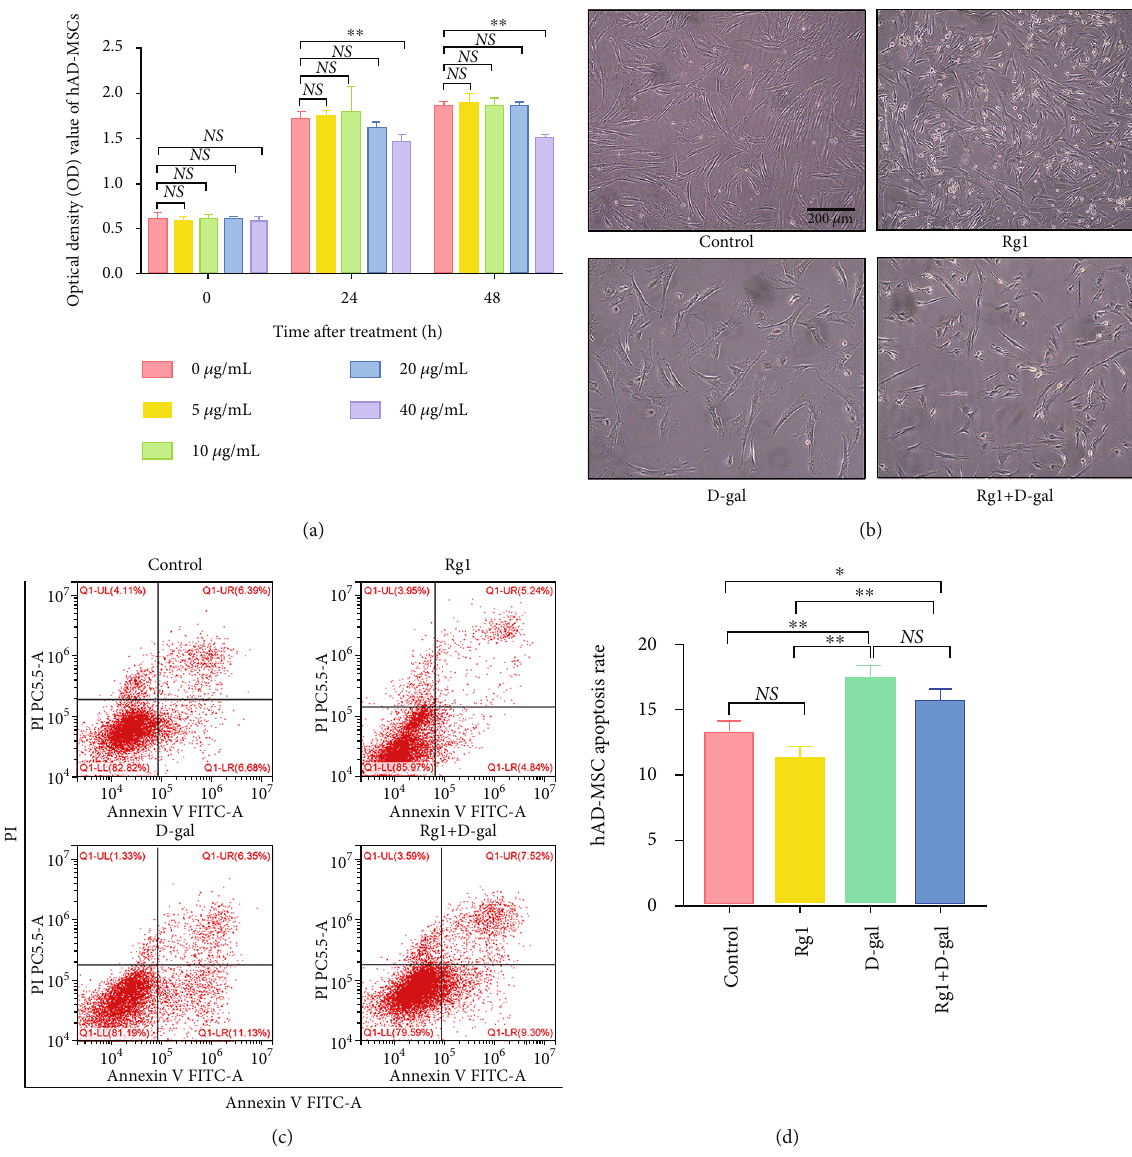
Figure 5: E ff ects of ginsenoside Rg1 on the apoptosis of hAD-MSCs. (a) The e ff ects of D-gal with di ff erent concentrations on the viability of hAD-MSCs were detected using CCK-8 assay. Optical density (OD) values at 450 nm of each concentration at 24 and 48 h after D-gal treatment were shown ( n =6). (b) The morphology of hAD-MSCs in the control, Rg1, D-gal, and Rg1+D-gal groups ( × 100). (c, d) The hAD-MSC apoptosis rates in the control, Rg1, D-gal, and Rg1+D-gal groups were analyzed (c) and compared (d) by fl ow cytometry ( n =3). A representative image of three independent experiments is shown in each group. Scale bars =200 μ m. NS: not signi fi cant, ∗ P < 0 : 05 and ∗∗ P < 0 : 01